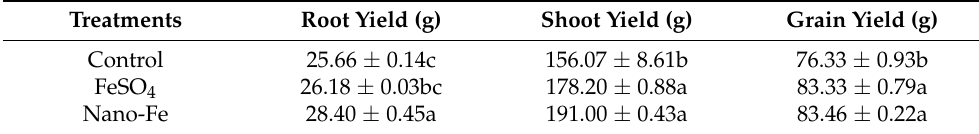
Table 1. Effect of exogenous Fe on the yield of various parts of rice. Treatments